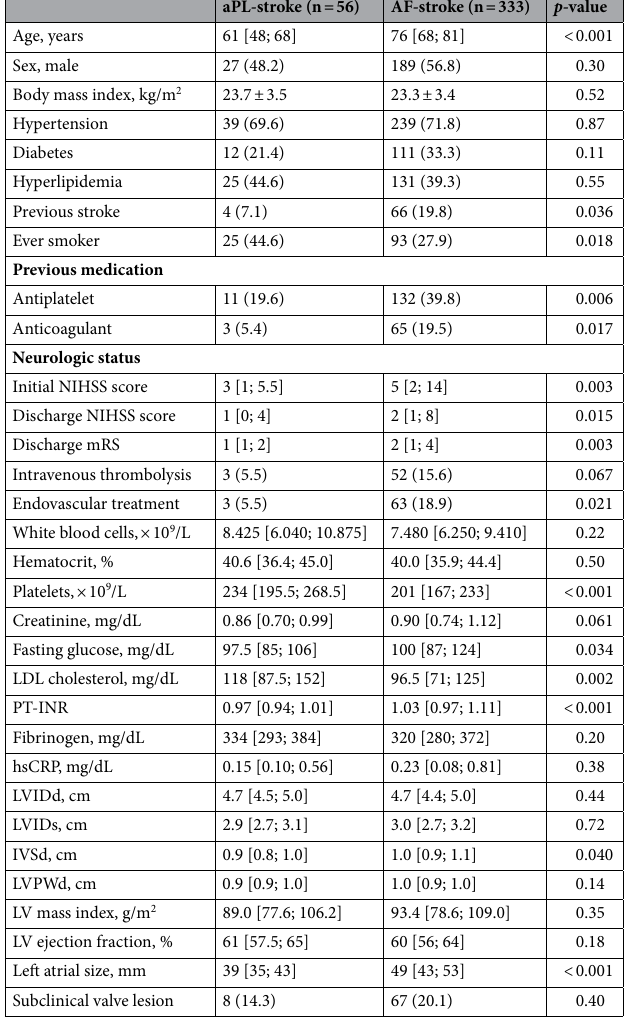
stroke, aPL-stroke antiphospholipid antibody-related stroke, hsCRP high-sensitivity C-reactive protein, IVSd interventricular septal thickness at end-diastole, LDL low-density lipoprotein, LV left ventricular, LVIDd LV internal diameter at end-diastole, LVIDs LV internal diameter at end-systole, LVPWd LV posterior wall thickness at end-diastole, mRS modified Rankin Scale, NIHSS National Institutes of Health Stroke Scale, PT-INR prothrombin time-international normalized